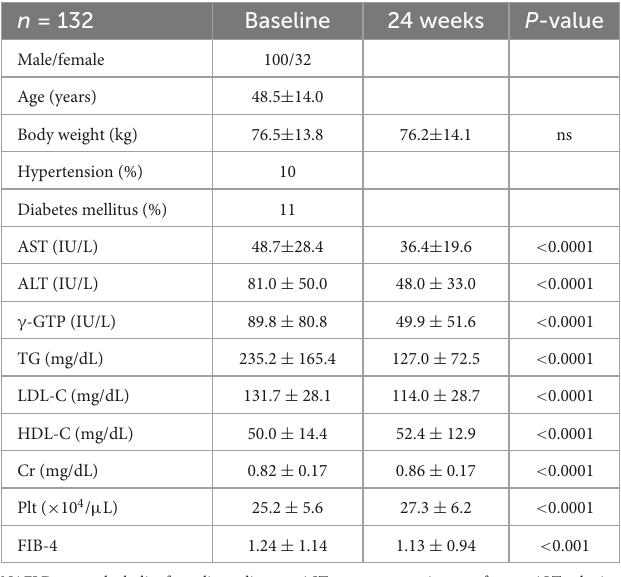
TABLE 1 Characteristics of patients with NAFLD at baseline and after 24 weeks of pemafibrate treatment.